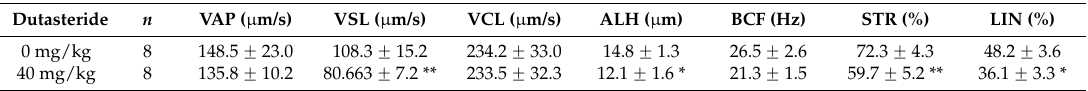
Table 1. Effect of dutasteride treatment on other sperm motion parameters between the two groups (mean ˘